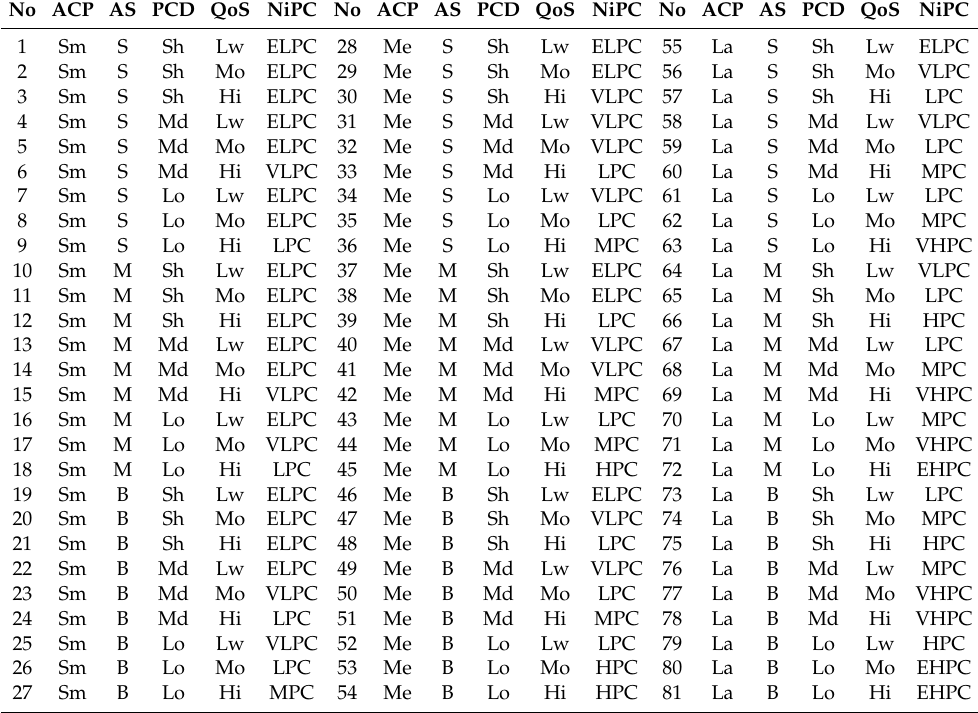
Table 5. FRB of FS-ANVPC.